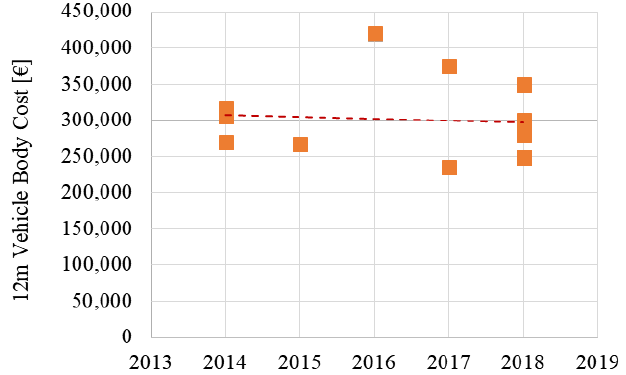
Figure 5. Purchase costs of 12 m electric buses excluding the batteries.